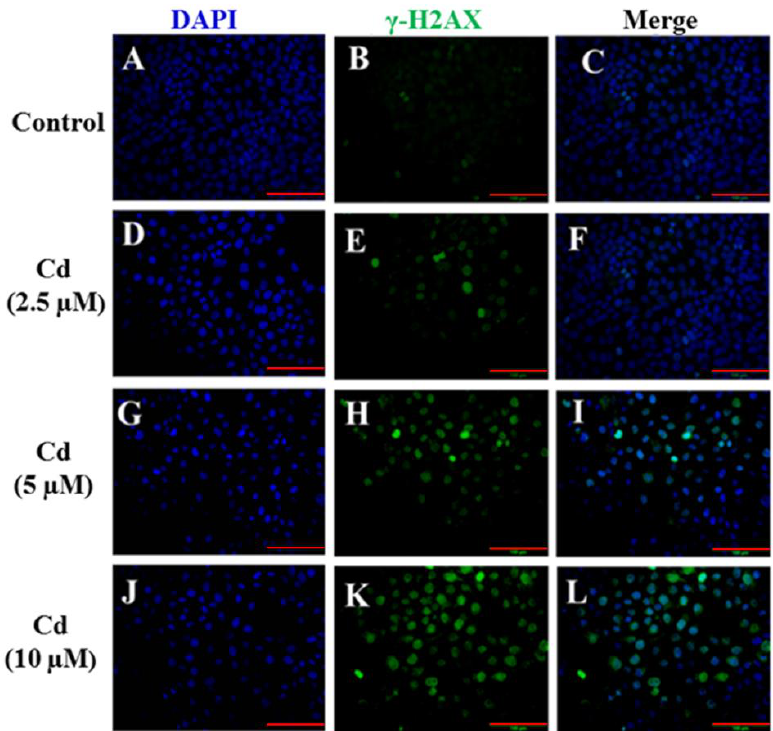
Figure 3. Cd induced DNA damage in HaCaT cells. Cells were exposed to 2.5-10 µM Cd for 24 h. The immunofluorescent staining of γ -H2AX (green: B,E,H,K ) was used to detect DNA damage in HaCaT cells, and the cell nuclei were labeled with DAPI ( blue: A,D,G,J ). The images were merged using Image-Pro Plus 6.0 software ( C, F, I, L ). (scale bars: 100 μm).